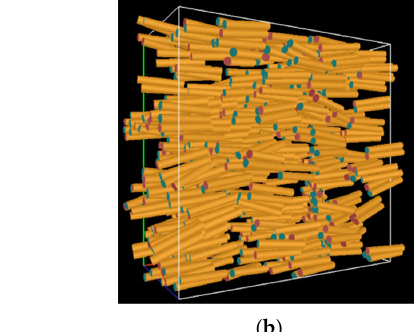
Figure 5. Stacking of ( a ) disks ( AR = 0.3) and ( b ) rods ( AR = 6) in monodisperse flows at solid volume fraction ν = 0.5. Particles that are not part of stacks are omitted in the figures.